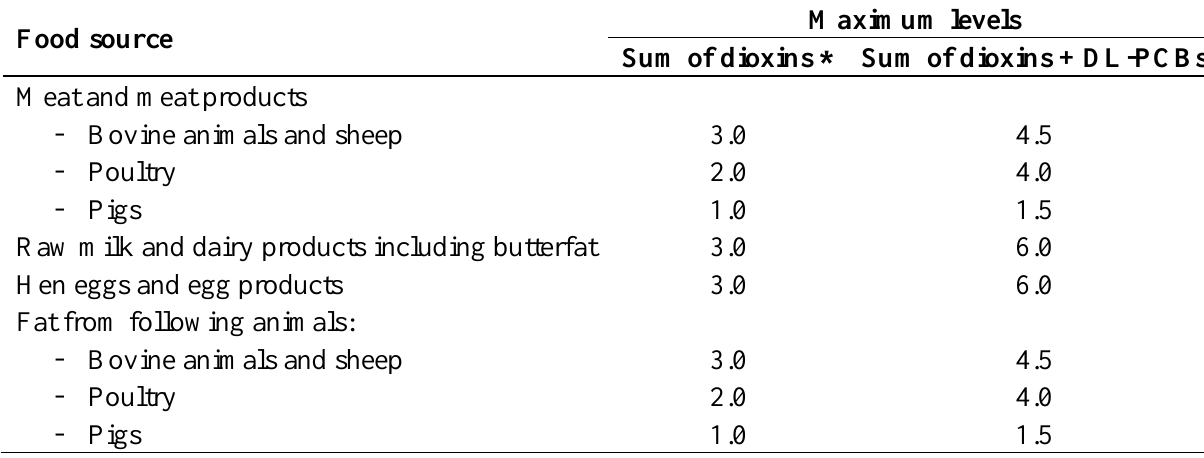
Table 1. Maximum levels of dioxins and DL-PCBs in animal-source food (pg TEQ/g fat) set by the European Union